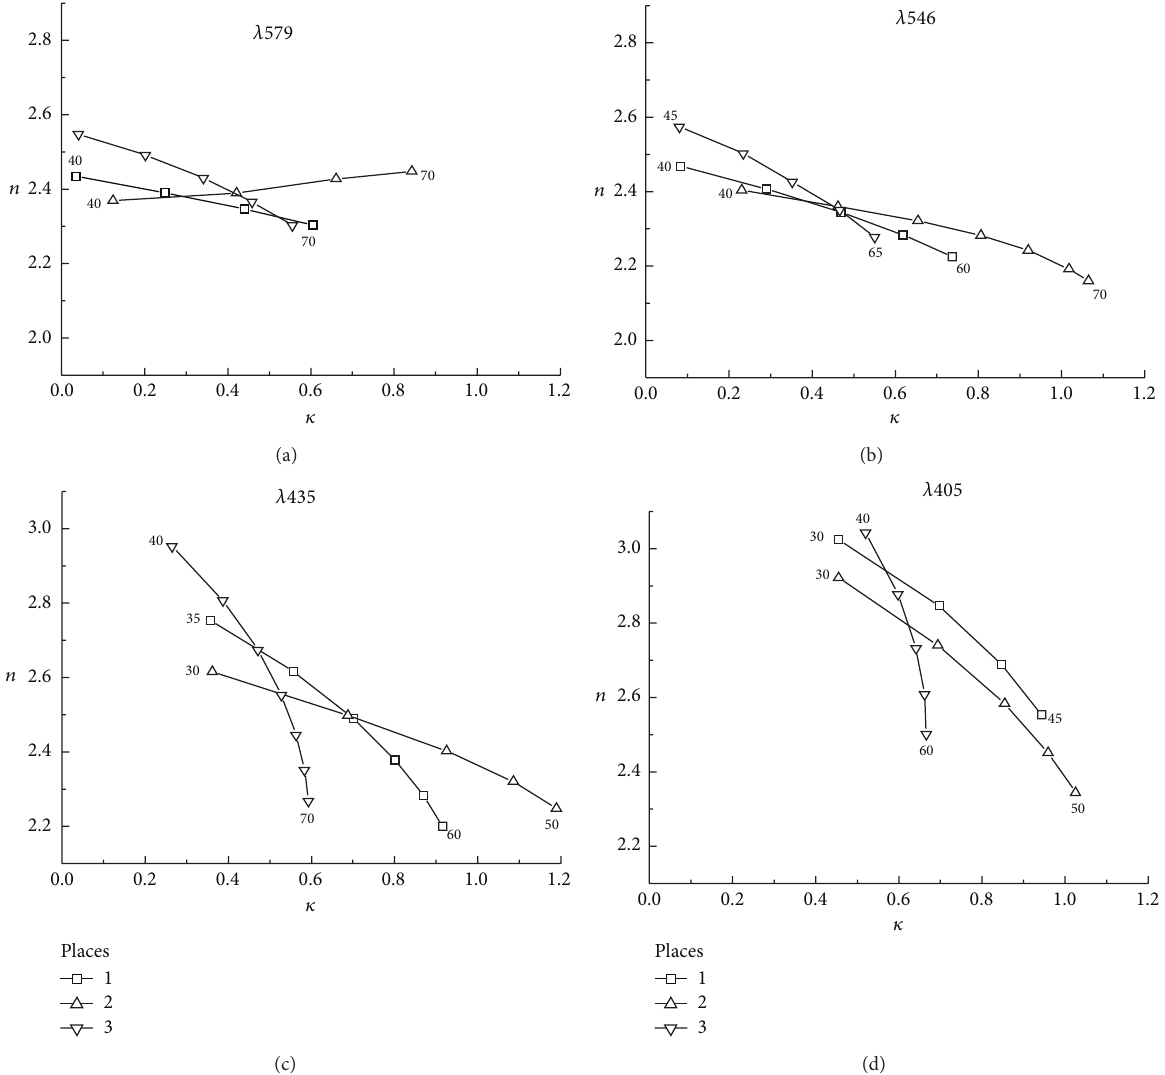
Figure 1: Range of values of refractive index 𝑛 and index of extinction 𝜅 (curves), calculated using experimental data for different places of the film F2 and different wavelengths 𝜆 (nm). The numbers near markers specify the film thickness in